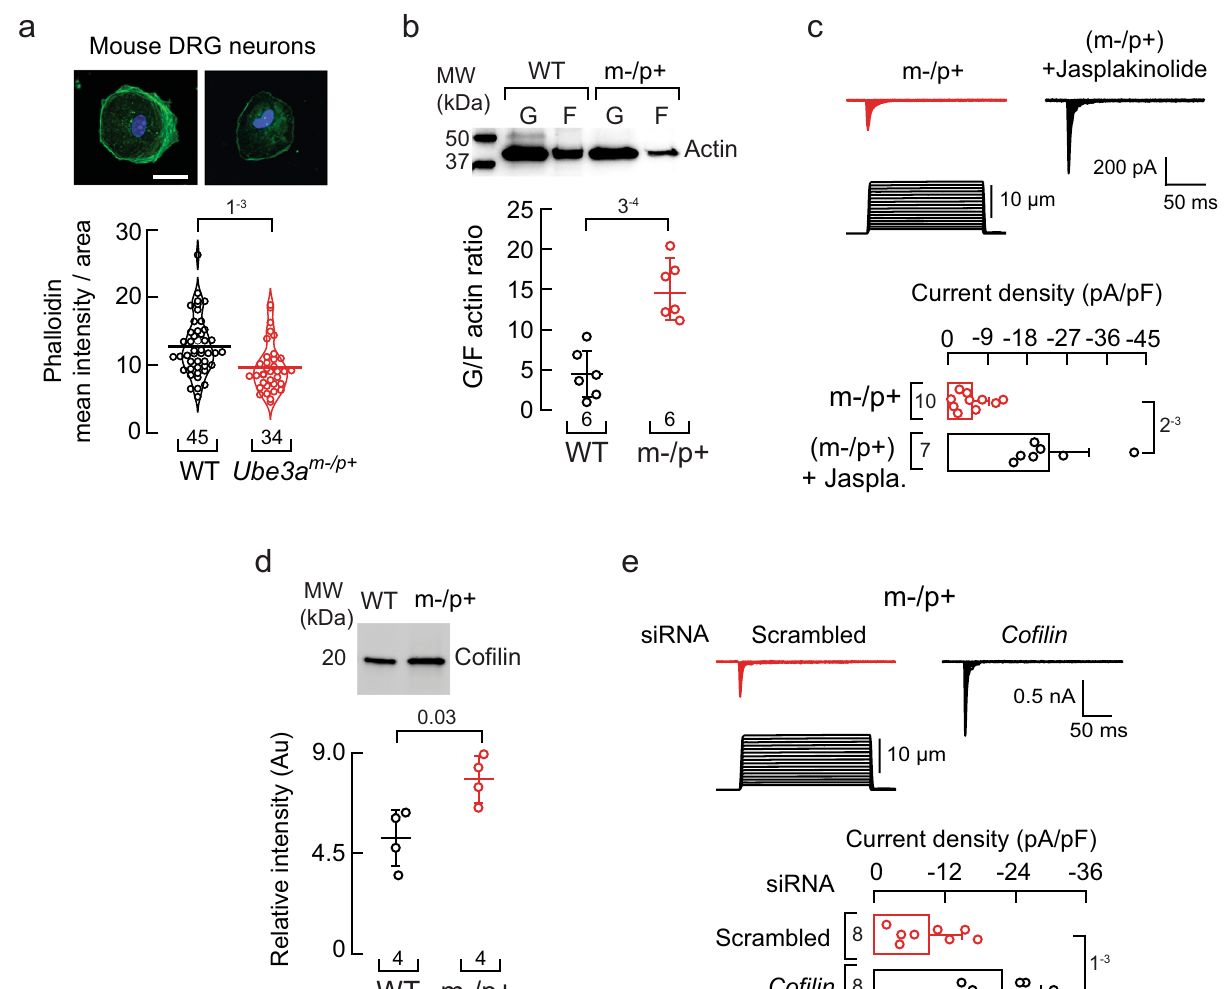
Fig. 3 | Ube3a m – /p+ DRG neurons display reduced F-actin and jasplakinolide treatment increases PIEZO2 currents. a Top, representative micrographs of culturedWTand Ube3a m – /p+ DRGneurons fi xedandstainedwithphalloidin(green) andDAPI(blue).Scalebar20 µ m.Bottom,phalloidinmeanintensitynormalizedby the neuron ’ s area is depicted as a violin plot with the means shown as horizontal bars. Two-tailed unpaired t -test ( t =3.41). b Top, western blot of soluble and insoluble actin (G and F, respectively) of WT and Ube3a m – /p + DRGs. Bottom, mean/ scatter-dotplotshowingG/Factinratios.Linesaremean±SD.Two-tailedunpaired t -test( t =5.43). c Top,representativewhole-cellpatch-clamprecordingsofPIEZO2 currentselicitedbymechanicalstimulation( − 60mV)ofcontrolandjasplakinolide (0.5 µ M; 18h)-treated Ube3a m – /p + DRG neurons. Bottom, current densities elicited